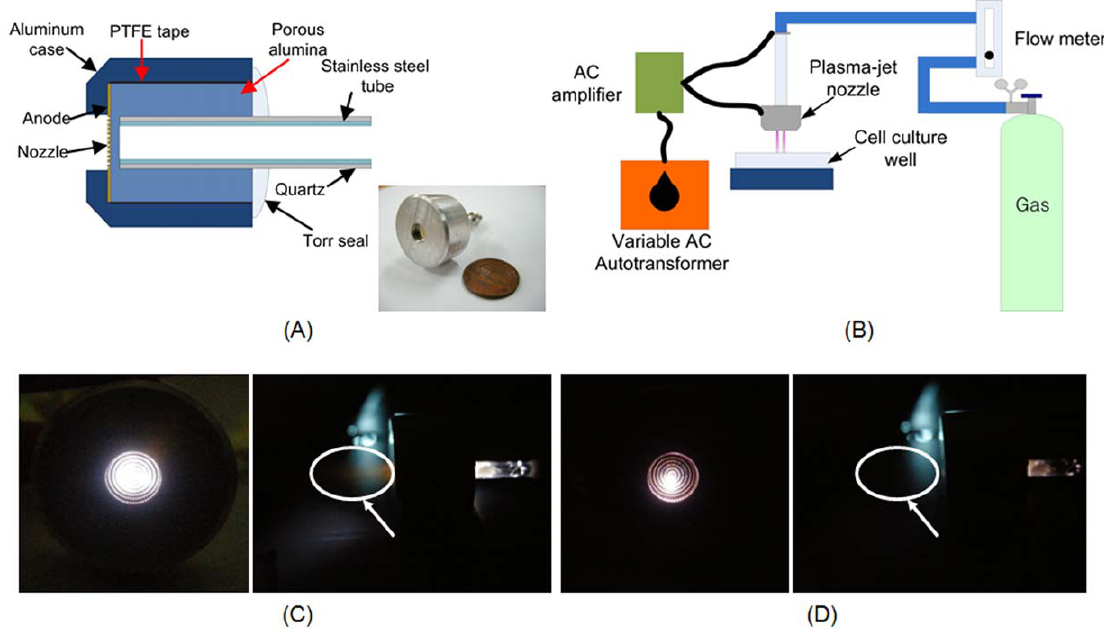
Figure 1. (A) Schematic structure of a plasma jet nozzle array. The inset shows a photograph of the fabricated plasma jet nozzle device. (B) A schematic view of the experimental setup for cell treatment. (C)–(D) Photographic images of the microplasma jet nozzle during discharges when (C) N 2 and (D) air are used. The left side shows a front view, while the right side shows a side view. The plasma jet is indicated as circles and arrows.